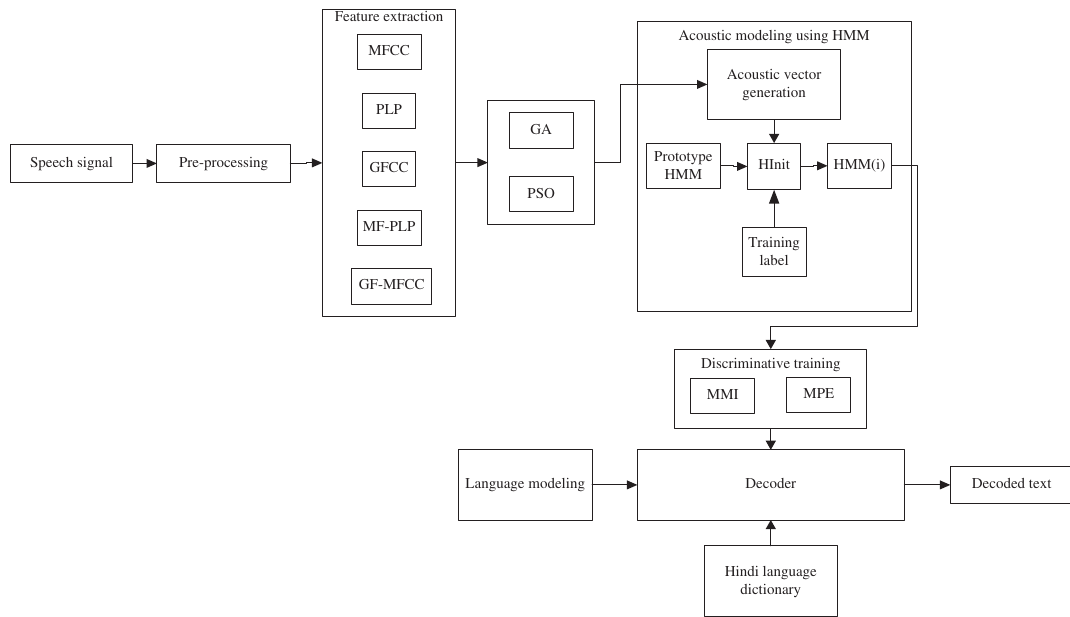
Figure 3: Proposed Architecture for Discriminatively Trained ASR System Using Optimized